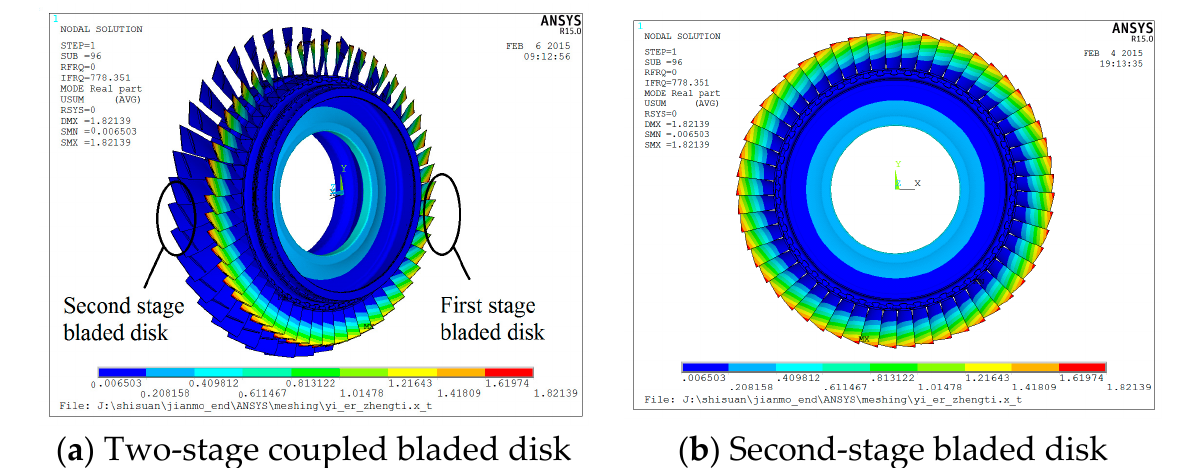
( b ) First-stage bladed disk Figure 18. Coupled vibration of the blade and disk in three segments. ( a ) Two-stage coupled bladed disk ( b ) First-stage bladed disk Figure 19. Four-pitch coupled vibration of the blade and disk. (2) As shown in Figures 20 – 24, coupled mode shapes of the second-stage bladed disk when the vibration is dominant.